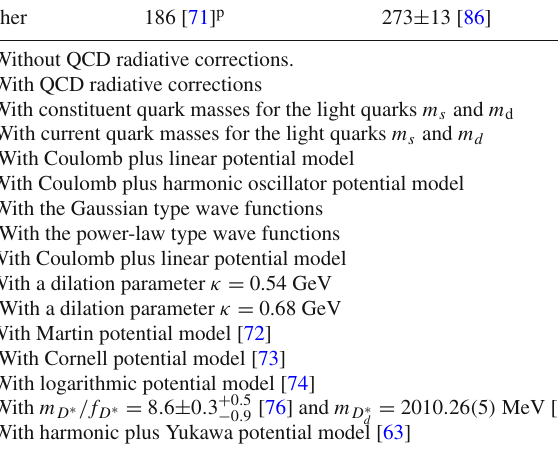
s and m d s and m d